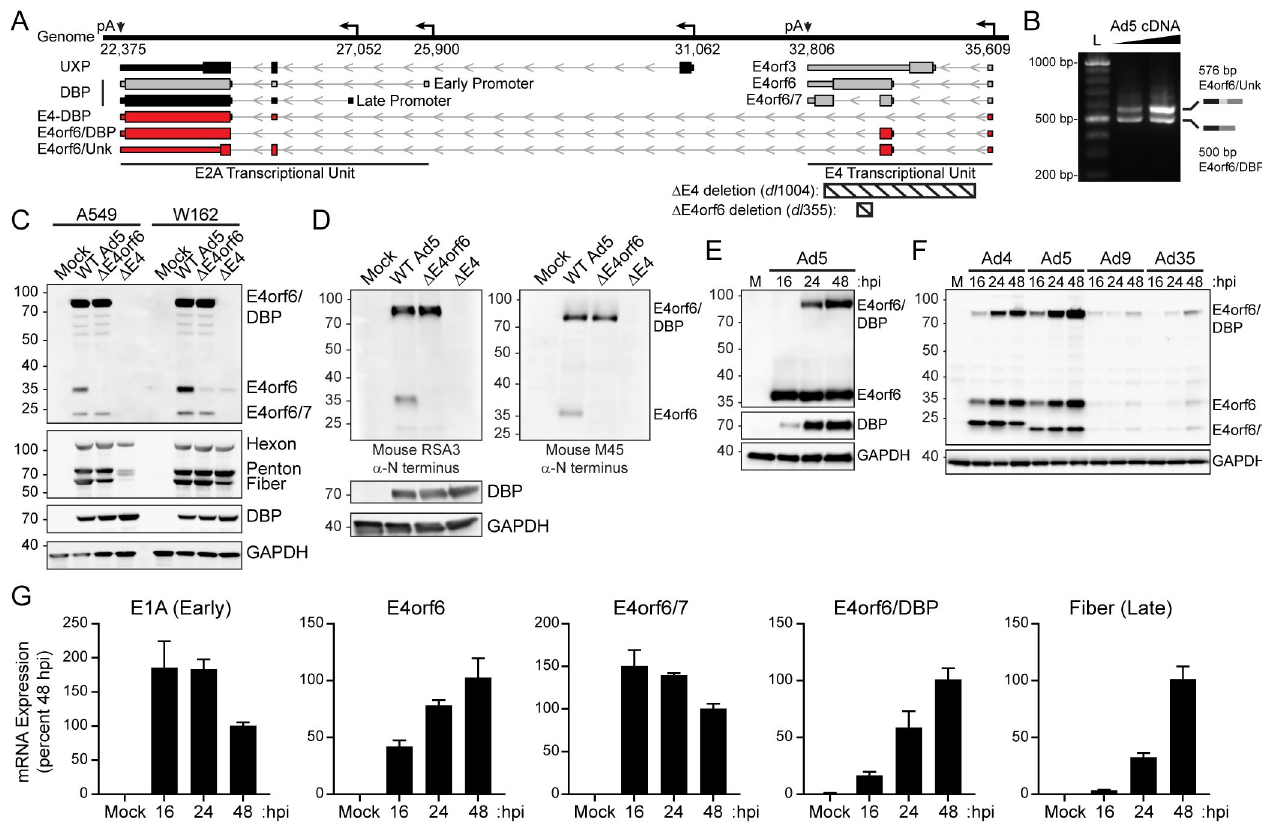
Fig 4. Novel fusion transcript between E4orf6 and DBP is expressed, translated, and conserved. (A) Enlarged transcriptome map of Ad5 E4 and E2A transcriptional units. Promoter transcription start sites are indicated with left-facing arrows, and cleavage and polyadenylation sites (pA) labeled with downward facing arrows. Novel E4-derived transcripts that terminate in E2A are highlighted in red. Ad5 mutant viruses dl 1004 and dl 355 contain deletions (indicated by hashed boxes) that remove most of the E4 region and splice donors ( Δ E4) or a 14-base deletion inside E4orf6 that only abrogates E4orf6 expression ( Δ E4orf6). (B) Reverse-transcriptase PCR on cDNA derived from Ad5-infection of A549 cells reveals characteristic bands of both E4orf6/Unk and E4orf6/DBP. L denotes DNA ladder and triangle indicates increasing cDNA concentration. (C) A549 or W162 cells were uninfected (mock) or infected with WT Ad5, Δ E4orf6, or Δ E4 viruses for 40 hours and proteins detected by immunoblot analysis. When blotting with antisera raised against the N-terminus of E4orf6, a prominent band is detected at the predicted size of E4orf6/DBP. This band is absent during Δ E4 infection and not observed in W162 cells where only the E4 region is provided in trans . Kilodalton size markers are shown to the left of each blot. (D) Infections and immunoblot analysis were performed as described in panel C . Two independently derived anti-N-terminal E4orf6 antibodies (RSA3 and M45) detect E4orf6/DBP. (E) Proteins expressed over a time- course of Ad5 infection in A549 were detected by immunoblot analysis at indicated hpi. (F) A549 cells were infected with adenoviruses from four different serotypes in a time-course. All tested adenovirus serotypes express a protein corresponding to E4orf6/DBP. (G) Quantitative reverse-transcriptase PCR was performed to demonstrate mRNA accumulation of Ad5 E1A (a representative early transcript), Fiber (a representative late transcript), and three E4orf6 containing transcript isoforms. Transcripts were normalized to expression level at 48 hpi and internal HPRT1 housekeeping gene.